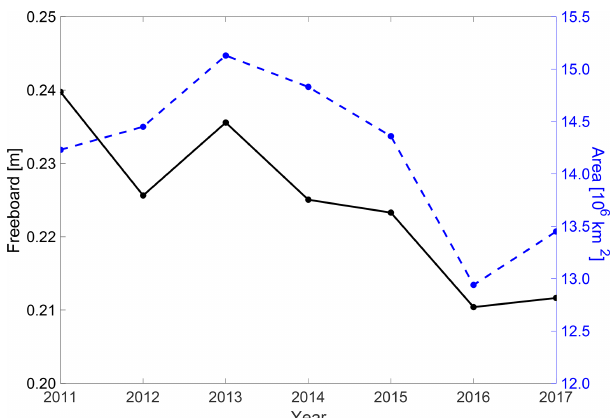
Figure 9. October monthly average Antarctic snow freeboard (black) and total sea ice area (blue) for reference. Sea ice area data are gathered from the NSIDC (Fetterer et al., 2017) and can be found at